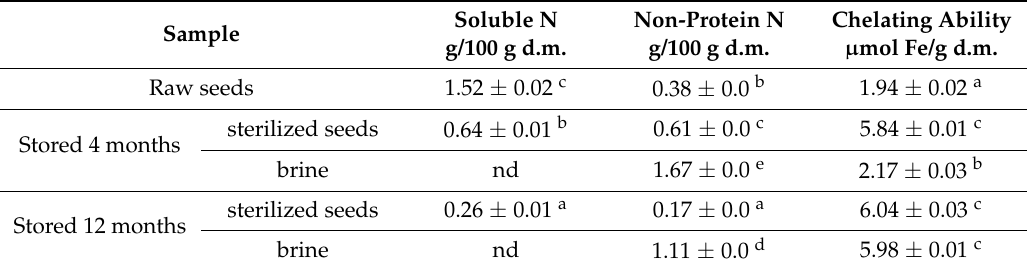
Values are mean ± SD. Data with the same superscript alphabets in columns are not significantly different.